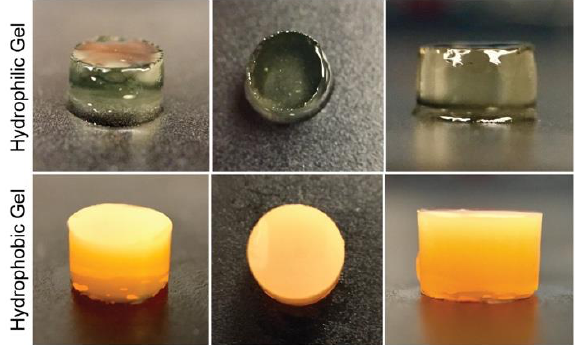
Figure 1. Polymerized drug-loaded bioinks. The upper row shows images of the polymerized hyaluronic acid-based bioink, loaded with lisinopril at a concentration of 40 mg/mL. This bioink has a W HANB value of 3% and a T L of 2 min. The bottom images show polymerized poly(ethylene glycol) diacrylate (PEGDA) gels with a W PEGDA value of 30%, a W EtOH value of 20%, and a T L of 1.0 min.